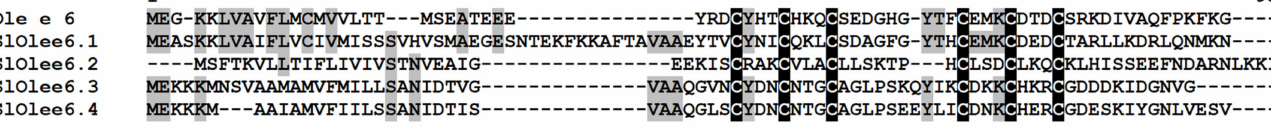
Figure 14. Multiple sequence alignment of S. lycopersicum Ole e 6 precursors and C. baccatum Ole e 6 (PHT46953.1). Cysteine residues are shaded black, and identical amino acids are shaded gray.